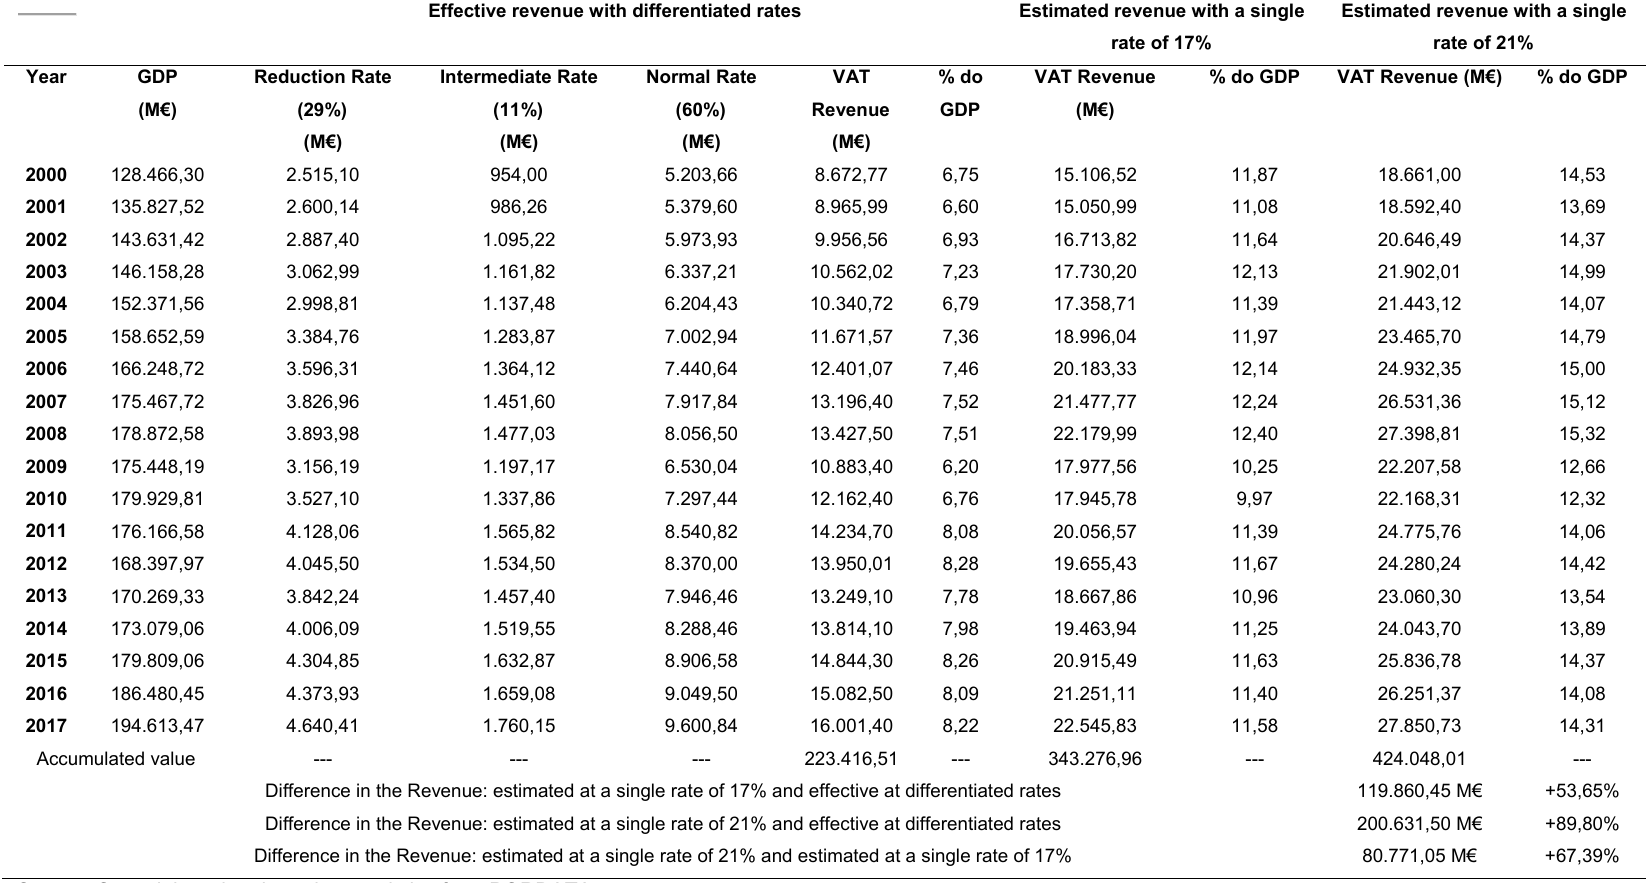
Table 1. Effective VAT revenue with differentiated rates and estimated VAT revenues with single rates of 17% and 21%.